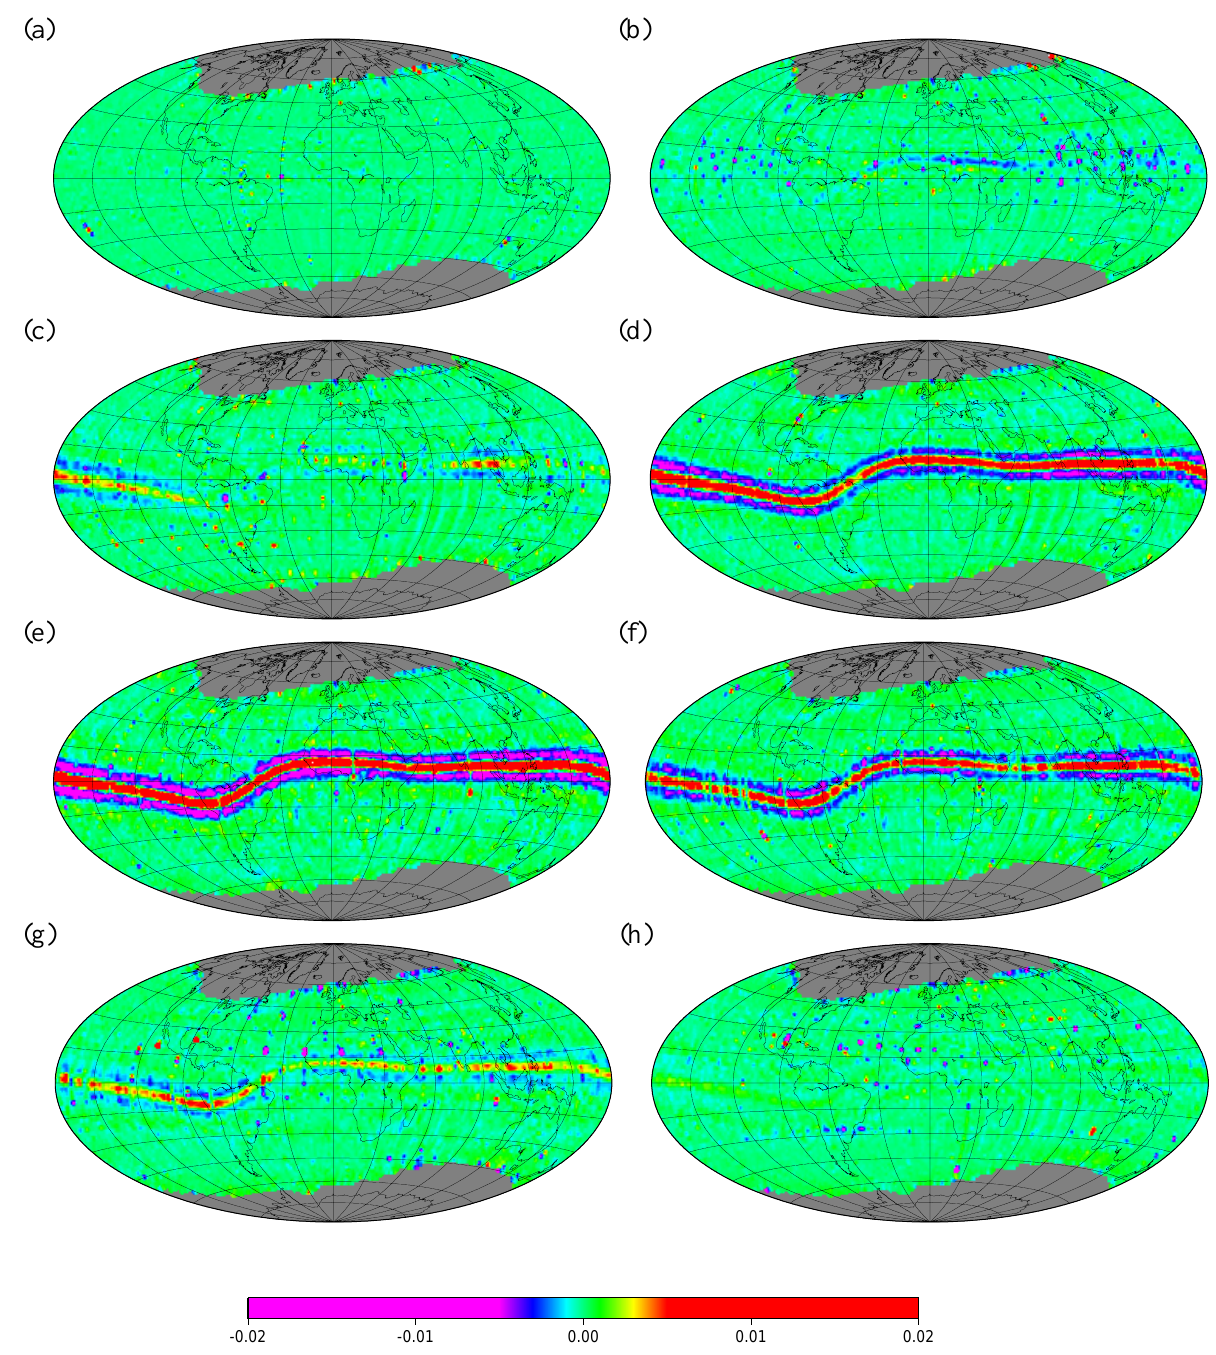
Fig. 3. Variation with local time of the along-track second derivative of the equatorial electrojet field (in nT/s 2 ), longitudinal component, at 00:00 (a) , 06:00 (b) , 08:00 (c) , 10:00 (d) , 12:00 (e) , 14:00 (f) , 16:00 (g) and 18:00 (h) . 01:30–02:30, etc., and applying the same analysis to the lon- gitudinal component. The result is an hour-by-hour movie of 26 the EEJ displacement around the world. Expectedly, the EEJ is made of the same three bands as in the LT maps and fol- lows the dip equator. Less expectedly, its length and